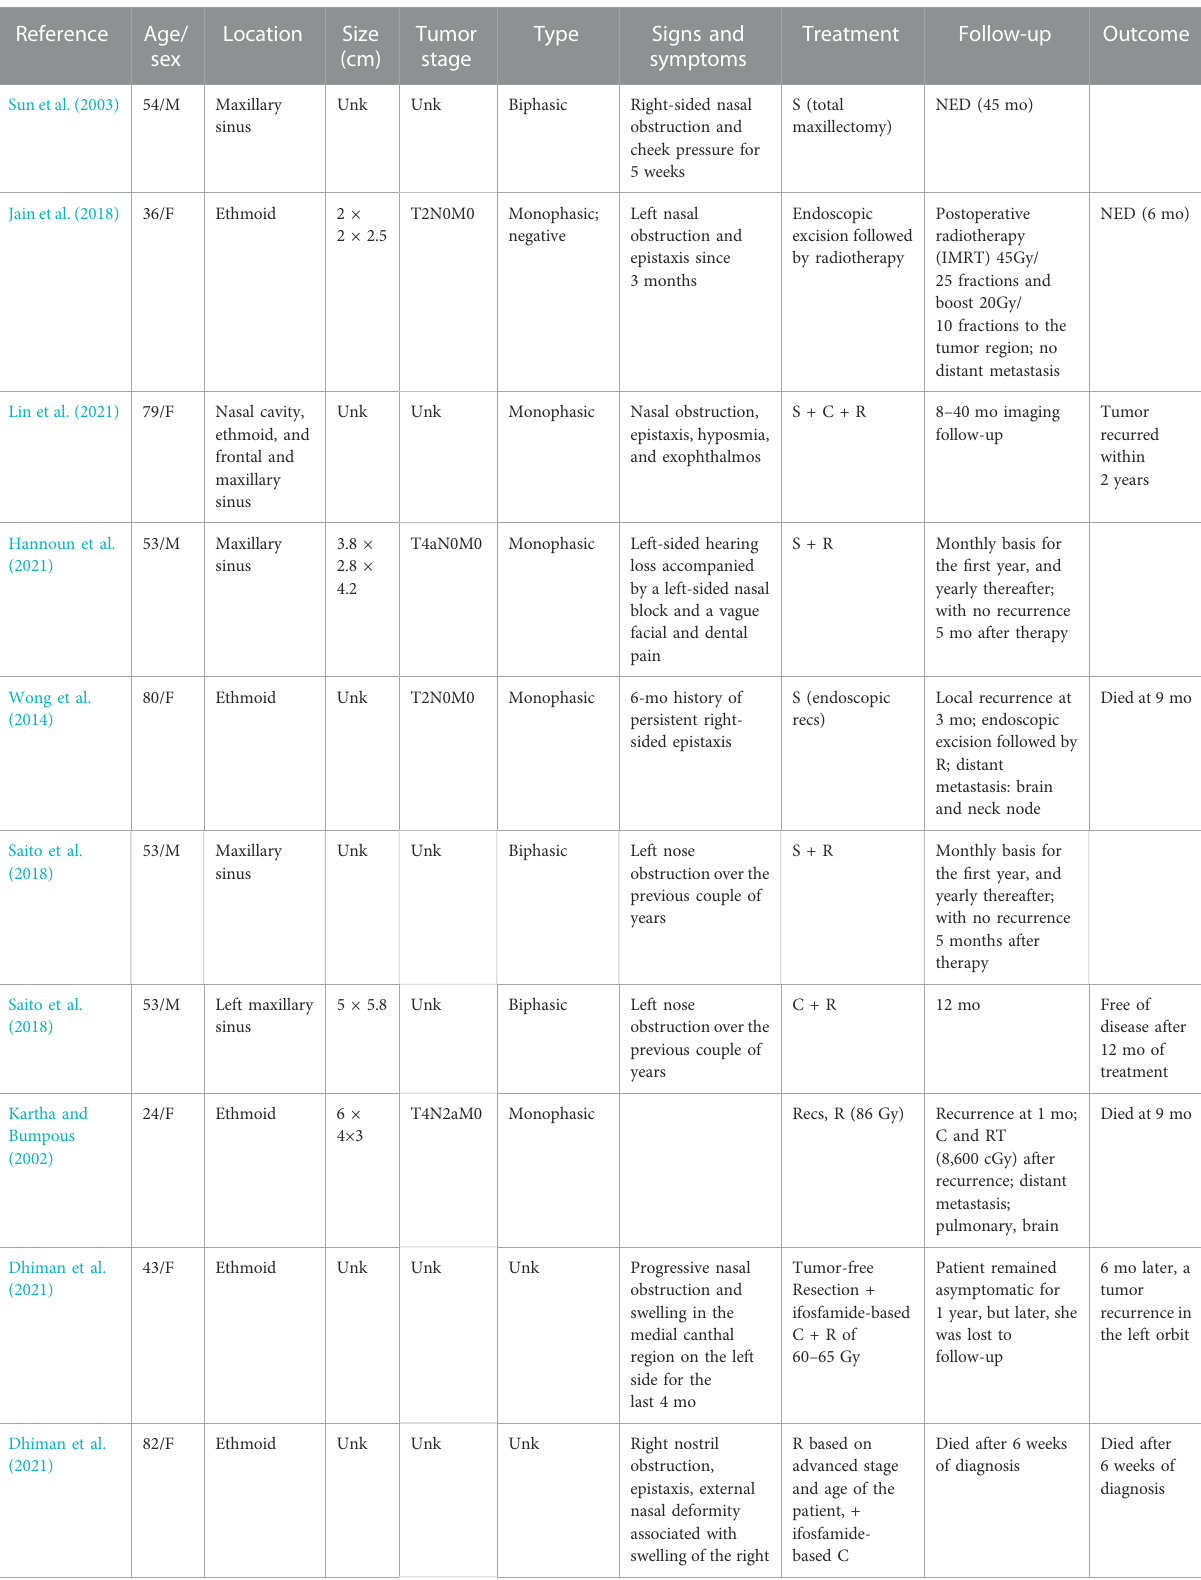
TABLE 3 Reported cases of synovial sarcoma in the paranasal sinus